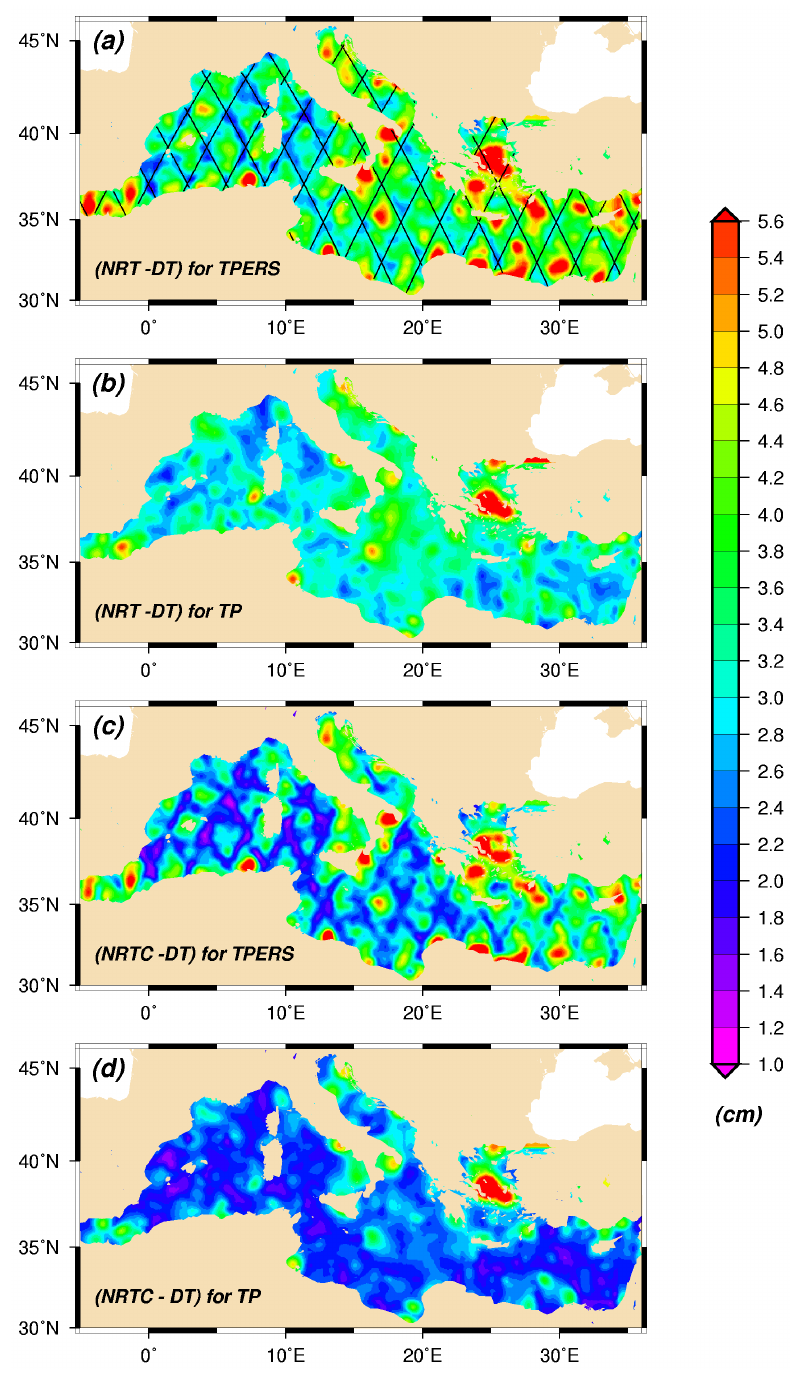
Fig. 1. Rms of the differences between NRT (near real time) and DT (delayed time) SLA maps. Units are in cm. (a) for combined maps of T/P and ERS, (b) for T/P maps, (c) idem (a) but with a center period of observations, (d) idem (b) but with a center period of observations. The black solid line corresponds to the T/P